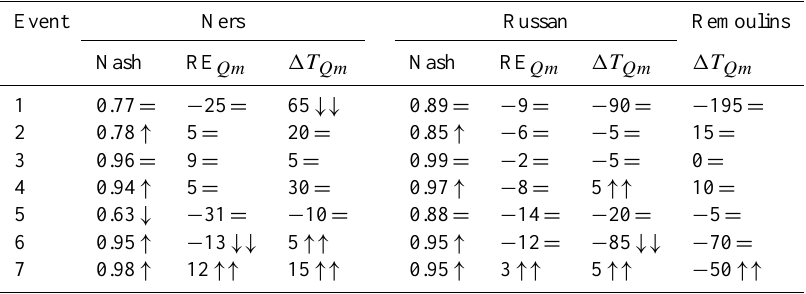
Table 9. COUPL OBS option results. Performance indexes at the Ners, Russan and Remoulins stations. The symbols on the right of the indexes characterise the gaps compared with the COUPL MOD option. ↓↓ : deterioration of more than 50%; ↓ : deterioration of between 5 and 50%; ↑ : improvement of between 5 and 50%; ↑↑ : improvement of more than 50%; = : close values, within ± 5%. Symbol also attributed to RE Qm , if the absolute difference is lower in ± 10%, and for 1T Qm , if the absolute difference is lower in ± 15min. Event Ners Russan Remoulins Nash RE Qm 1T Qm